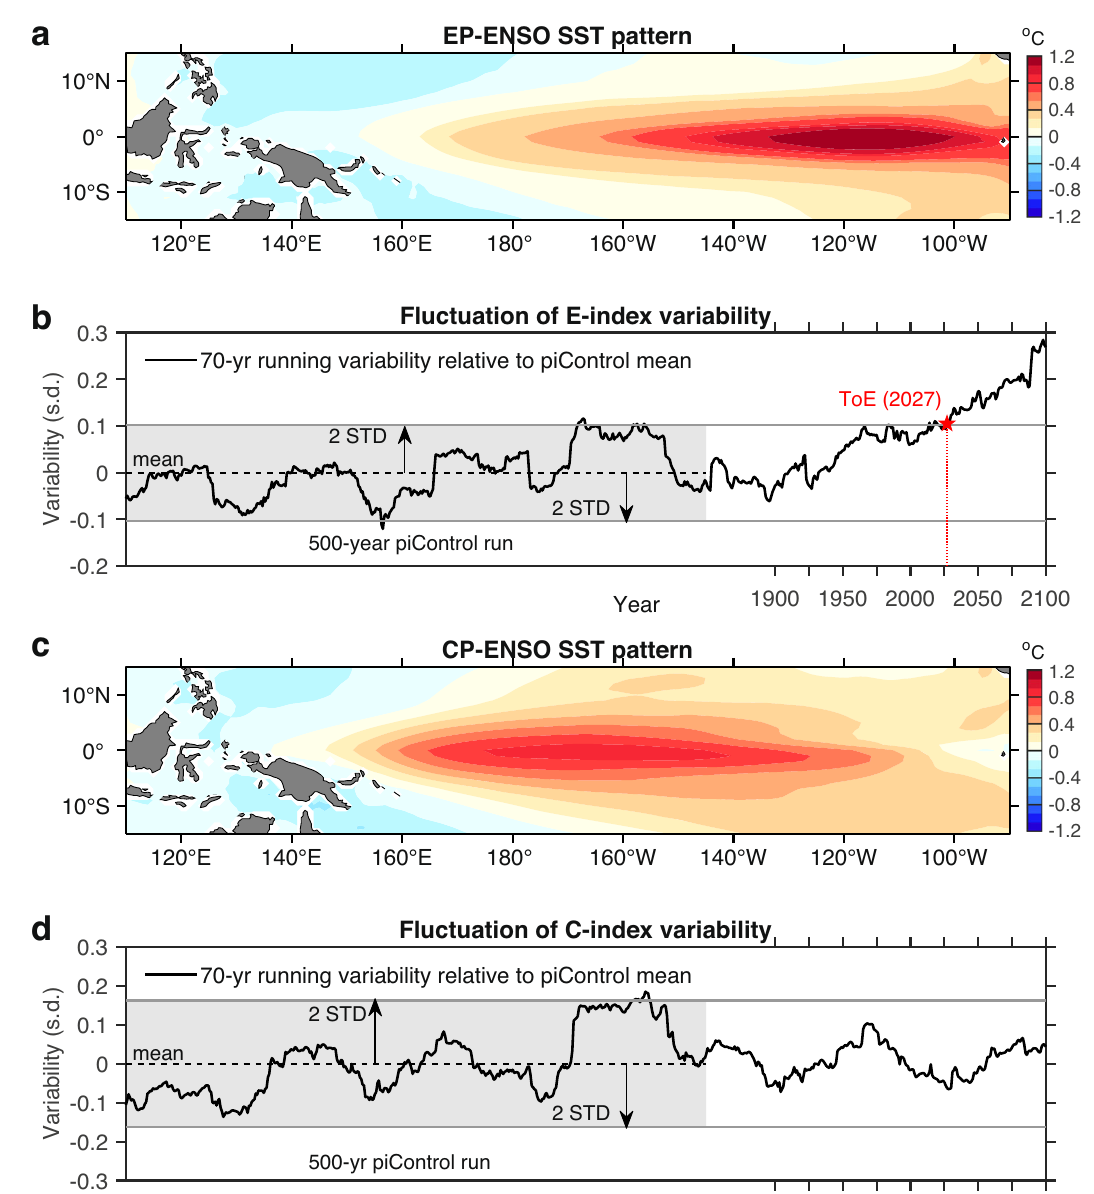
Fig. 1 | Emergence of El Niño-Southern Oscillation (ENSO) sea surface tem- perature (SST) variability change from noise. Shown is an illustrative example from GFDL-ESM4, a climate model able to realistically simulate non-linear ENSO characteristics (see Supplementary Fig. 1). a Spatial pattern of eastern-Paci fi c (EP) ENSO, obtained by regressing grid-point SST anomalies (°C) onto E-index over the wholeperiodfrompiControlto2100. b EvolutionofE-indexvariability(blacksolid line; s.d.) relative to its mean pre-industrial level (dashed black line), in a 70-year